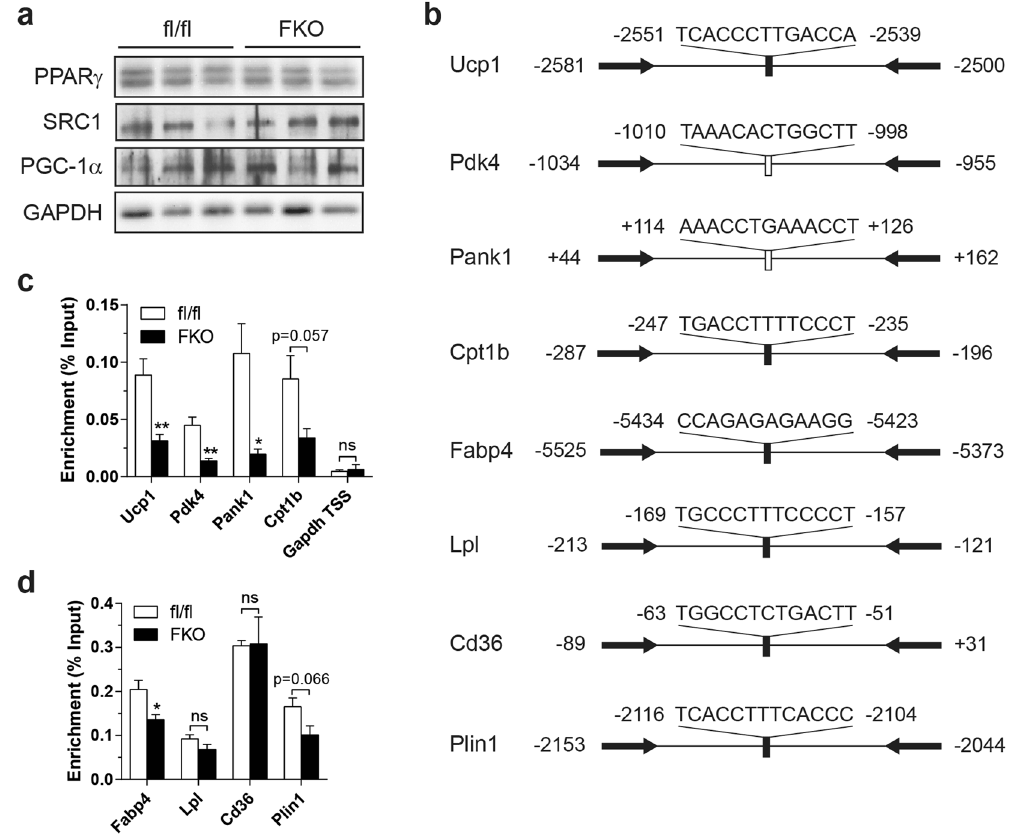
Figure 3. Impaired respiratory capacity influences the recruitment of PPAR γ . ( a ) Immunoblot of PPAR γ , SRC1, PGC-1 α and GAPDH (loading control) in BAT. ( b ) Schematic diagram depicting the positions of primers used for ChIP and the positions/sequences of PPREs of the genes assessed by ChIP assays. Filled bar: previously identified PPRE; Open bar: putative PPRE. The arrows indicate the positions of primers. ( c , d ) ChIP analysis of thermogenic and oxidative gene enhancer/promoters ( c ) and lipogenic gene promoters ( d ) using PPAR γ antibody in BAT. 12–14 week-old male at 30 °C. ( c , d ) n = 4–5. Data are mean ± SEM. * P < 0.05, ** P < 0.01, two-tailed unpaired Student’s t- test ( c , d